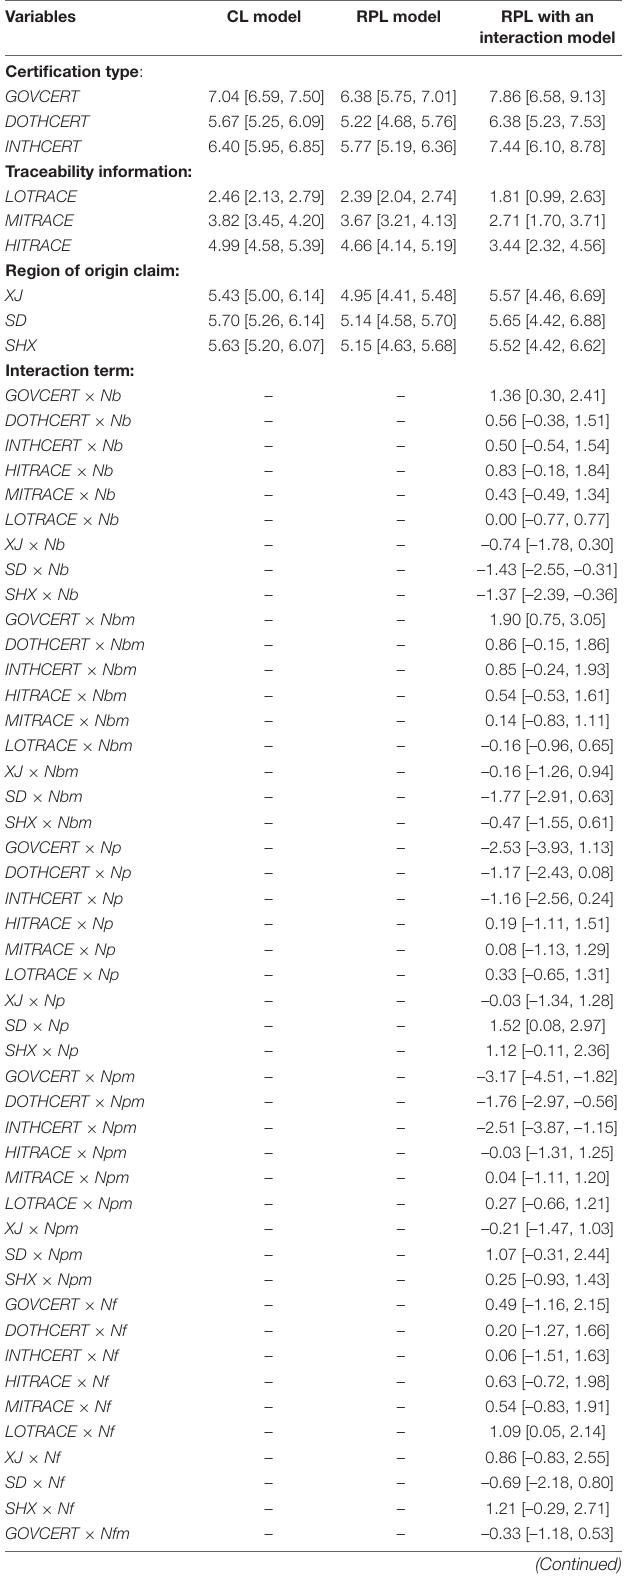
TABLE 3 | Willingness to pay for each attribute level estimated by CL, RPL, and RPL with an interaction model.